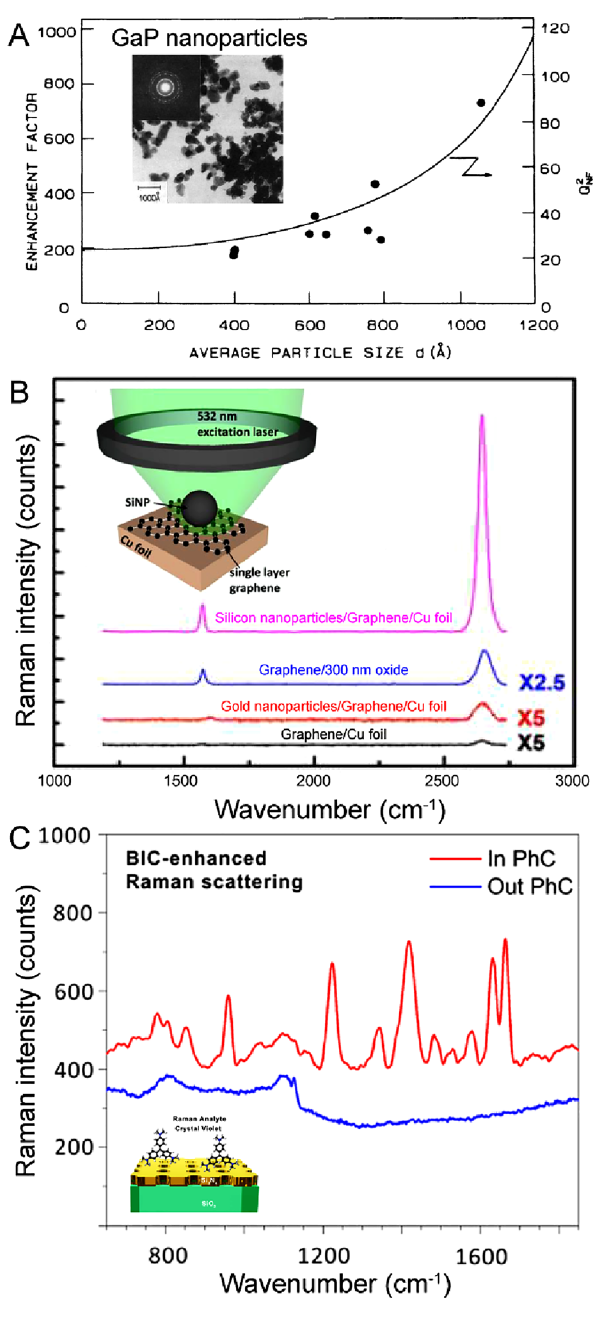
Figure 3: Surface-enhanced Raman spectroscopy. (A) Surface-enhanced Raman signal using high-refractive-index gallium phosphide nanoparticles of varying particle size. Adapted fromthestudybyHayashietal.[23].(B)ComparisonofRamansignal from graphene from different surface architectures. The large electromagnetic fi eldsproducedbythecouplingbetweenthesilicon nanoparticle and metal substrate outperform the other surfaces. Adapted from the study by Tseng et al. [56] (C) Surface-enhanced Raman signal using a silicon nitride photonic crystal (PhC), which supports a bound state in the continuum (BIC). Adapted from the study by Romano et al.